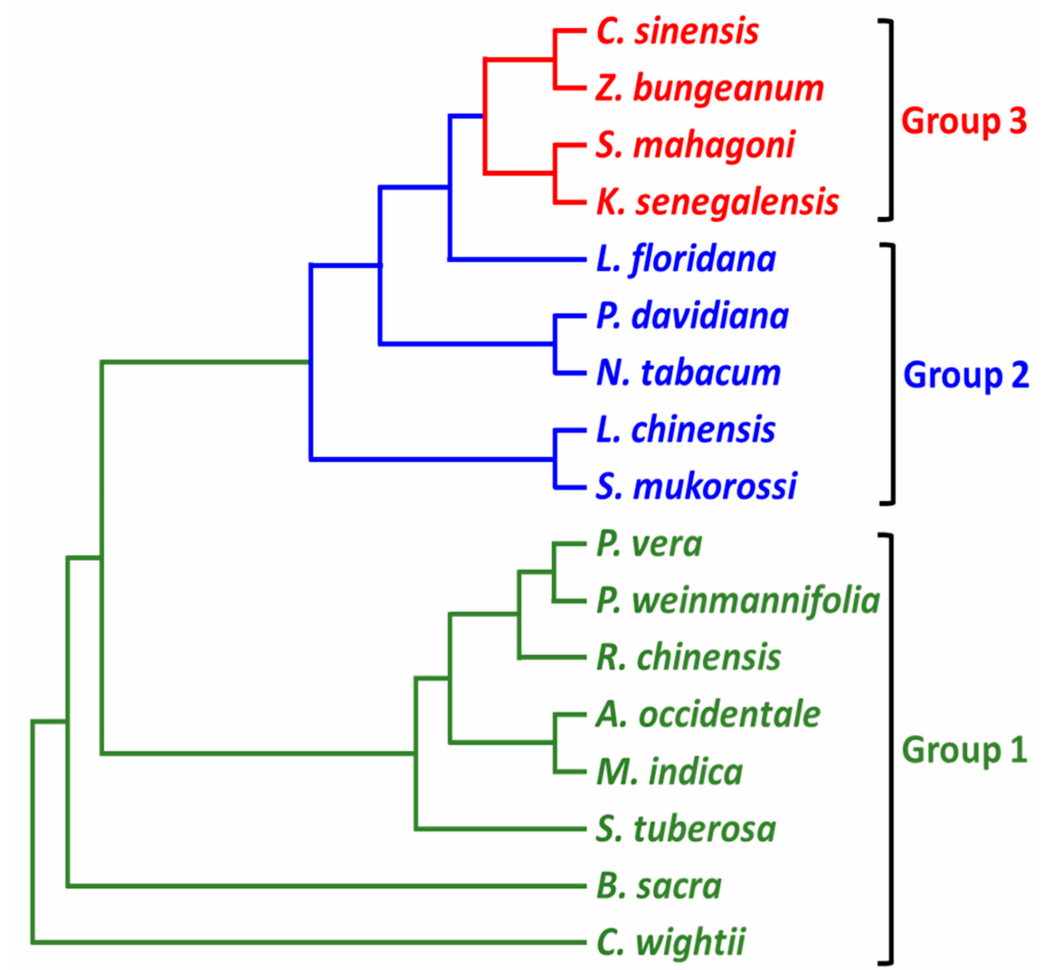
Figure 3. Phylogenetic relationships constructed from the complete chloroplast genome sequences of the members of the Spindales